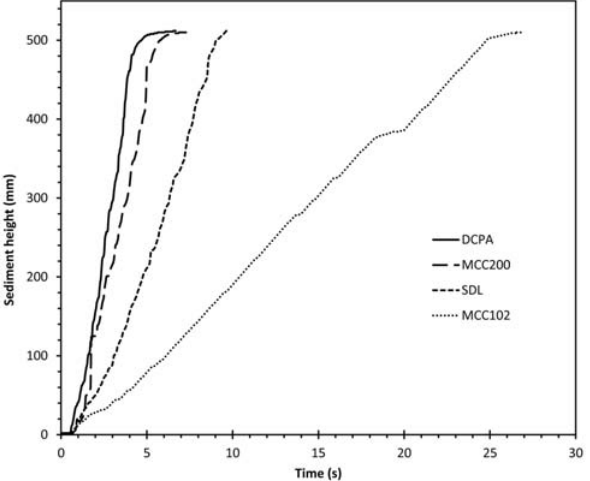
Figure 8. Sediment height increase over time in pipe with a closed outlet for all tested materials: dicalcium phosphate anhydrous (DCPA), microcrystalline ce llulose MCC102 and MCC200, and spray-dried lactose (SDL).